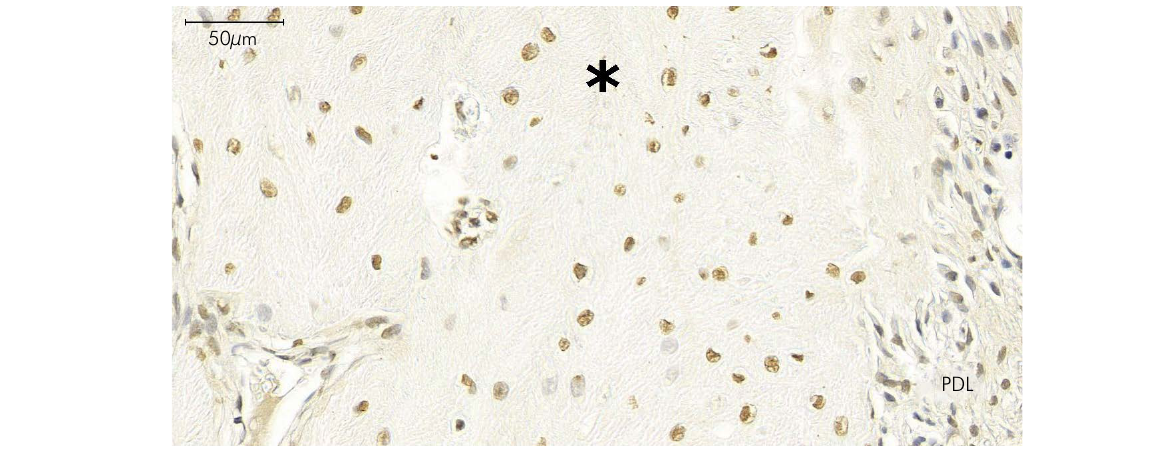
Figure 6. Representative immunohistochemical reactivity (arrows) for OPN in the 640J-LD group. Numerous immune-positive osteocytes located in the newly-formed alveolar bone tissue (asterisk) which is adjacent to the PDL (Immunohistochemical Staining; Bar = 50 µm).